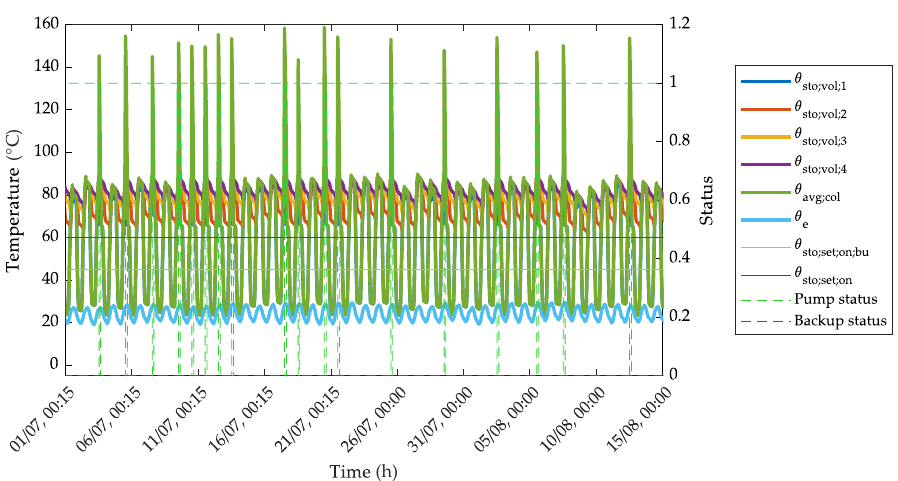
Figure 10. The effect of larger solar surface on system temperatures in summer months. Time step: 15 min.